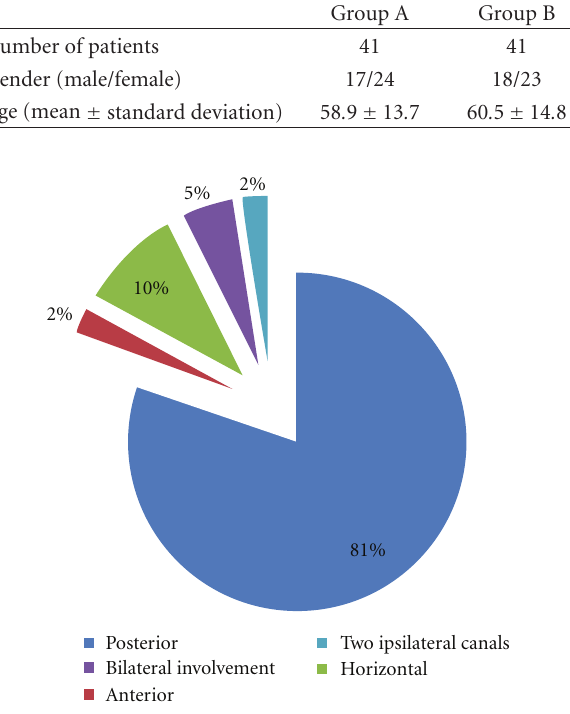
Figure 1: Semicircular canal involvement in our patients.